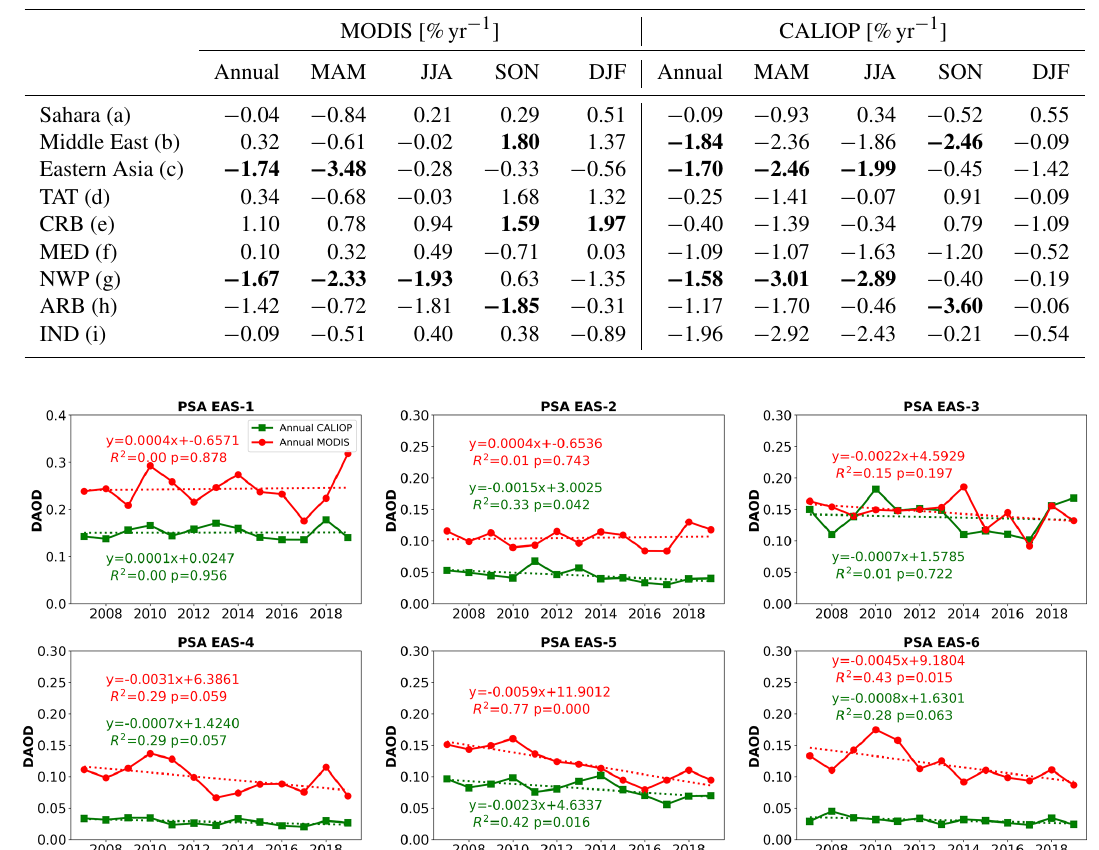
Figure 16. Interannual variability of CALIOP (green) and MODIS (red) DAOD in the six potential dust source areas in eastern Asia (refer to Fig. 8).